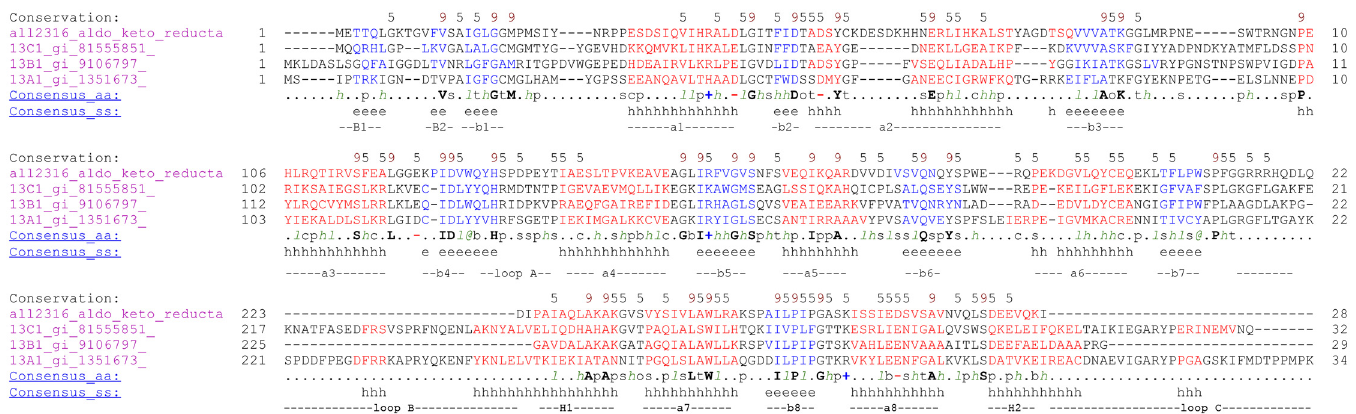
Fig 2. Sequence alignment of Anabaena 7120 aldo- keto reductase All2316 and members of AKR13 family using PROMALS3D multiple sequence and structure alignment server (prodata.swmed.edu/promals3d/). Representative sequences are colored according to predicted secondary structures (red: alpha-helix, blue: beta-strand). Consensus predicted secondary structure symbols: alpha-helix: h; beta-strand: e. Consensus amino acid symbols are: conserved amino acids are in bold and uppercase letters; aliphatic (I, V, L): l; aromatic (Y, H, W, F): @; hydrophobic (W, F, Y, M, L, I, V, A, C, T, H): h; alcohol (S, T): o; polar residues (D, E, H, K, N, Q, R, S, T): p; tiny (A, G, C, S): t; small (A, G, C, S, V, N, D, T, P): s; bulky residues (E, F, I, K, L, M, Q, R, W, Y): b; positively charged (K, R, H): +; negatively charged (D, E):-; charged (D, E, K, R, H): c.